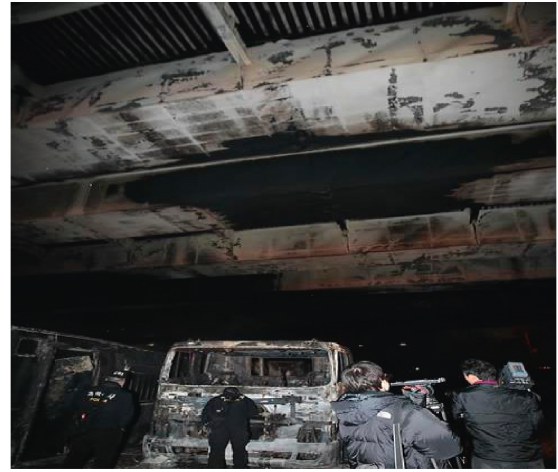
Figure 1: Bucheon overpass. Figure 2: MacArthur Maze